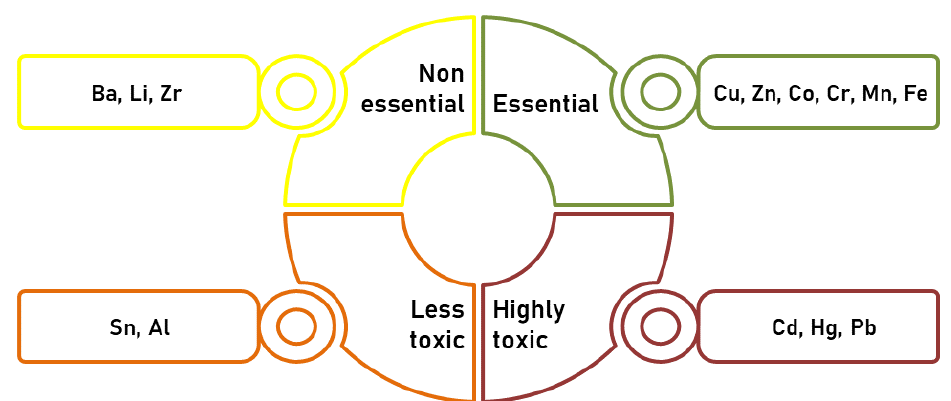
Figure 2. Heavy metal classification according to health importance (data modified from Raikwar et al. [20]).